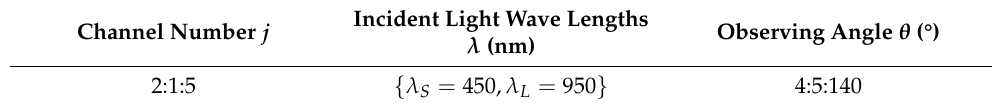
Table 1. The optional optical